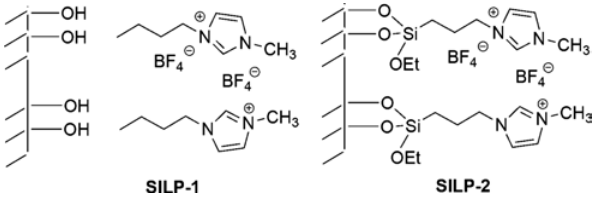
Figure 1: SILP phases used for the preparation of supported